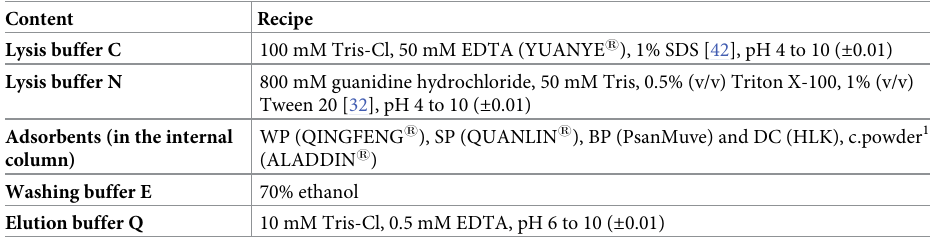
Table 2. The buffers and adsorbents.